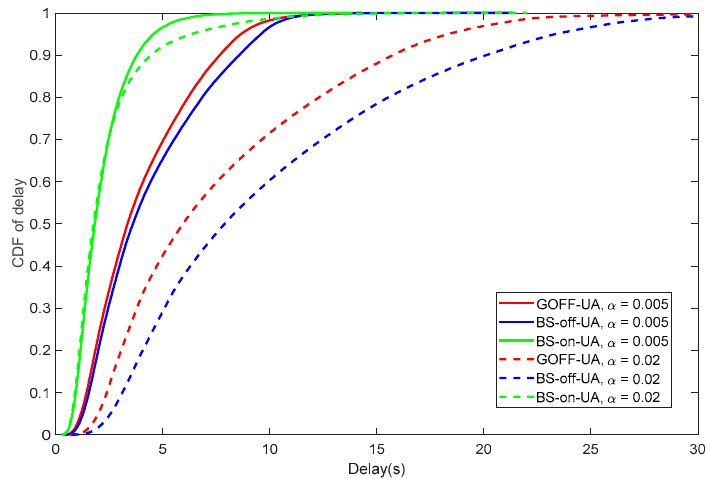
Figure 11. Comparison of time delay CDF of three schemes.